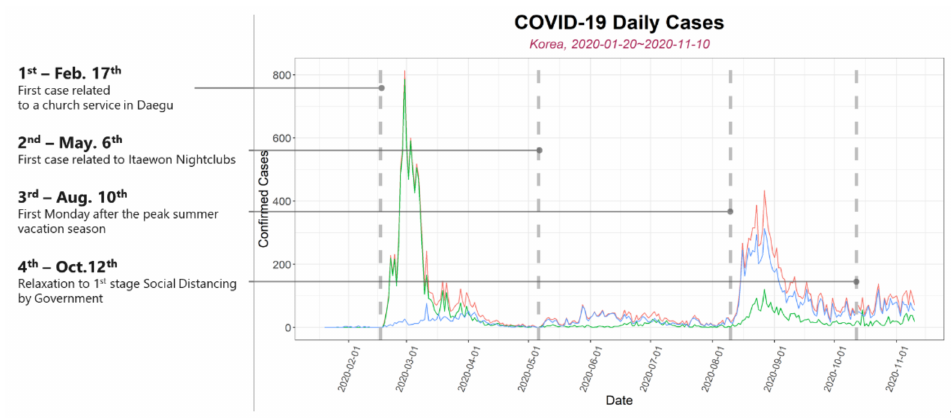
Figure 3. Daily Confirmed Cases of South Korea with the Breakpoint Information. Daily confirmed cases of Domestic, SeoulMetro, Non-SeoulMetro is represented in red, blue, and green